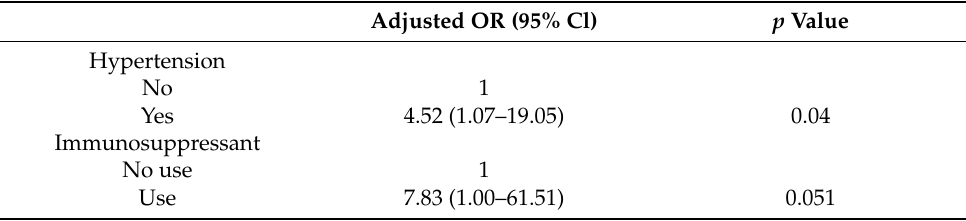
Table 5. Multivariate logistic regression for ≥ 20% decline in eGFR over time in IgMN